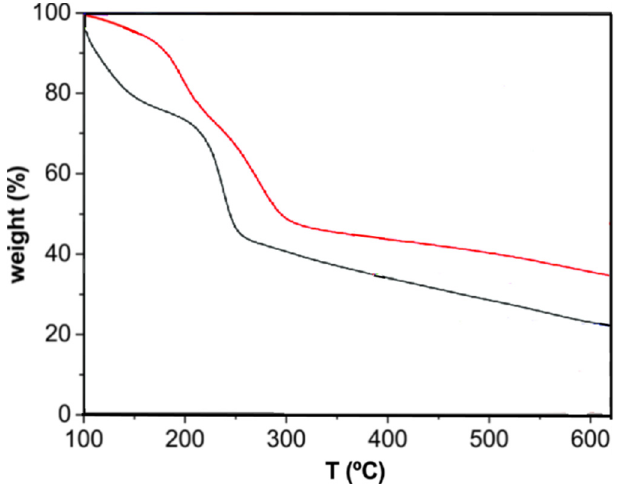
Figure 6. TGA thermograms under nitrogen for the reference GO * (black) and EGO 4.